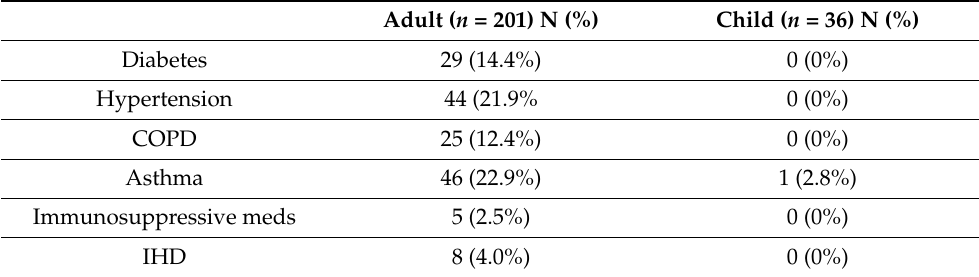
Table 1. Percentage of patients attending the COVID-19 service with recorded co-morbidities.